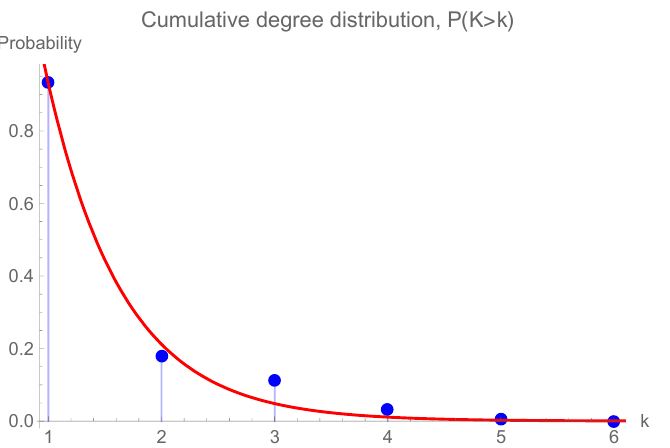
Figure 7. Degree distribution of Barcelona subway network.